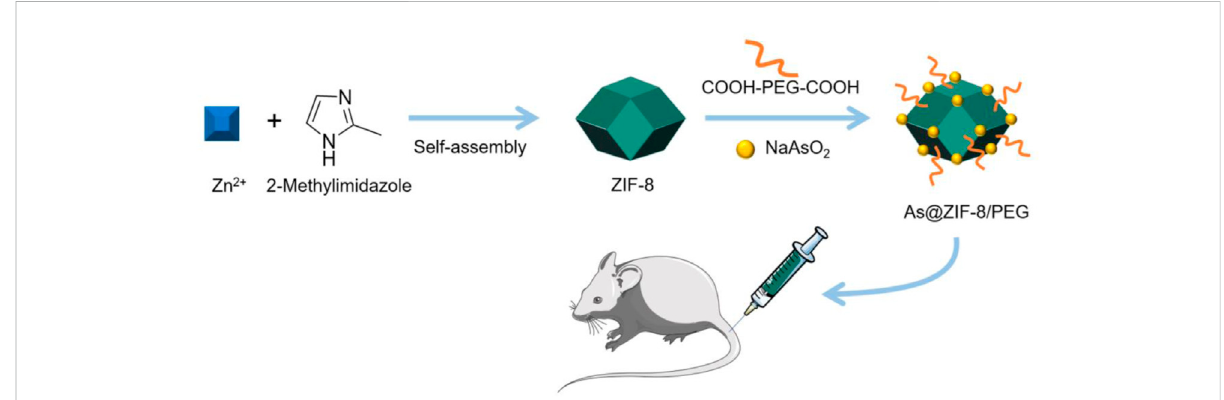
FIGURE 5 Synthesis and application of As@ZIF-8/PEG NPs. The schematic pieces were provided by Smart Medical Art and adapted [http://www.servier. com]. Servier Medical Art by Servier is licensed under a Creative Commons Attribution 3.0 Unported